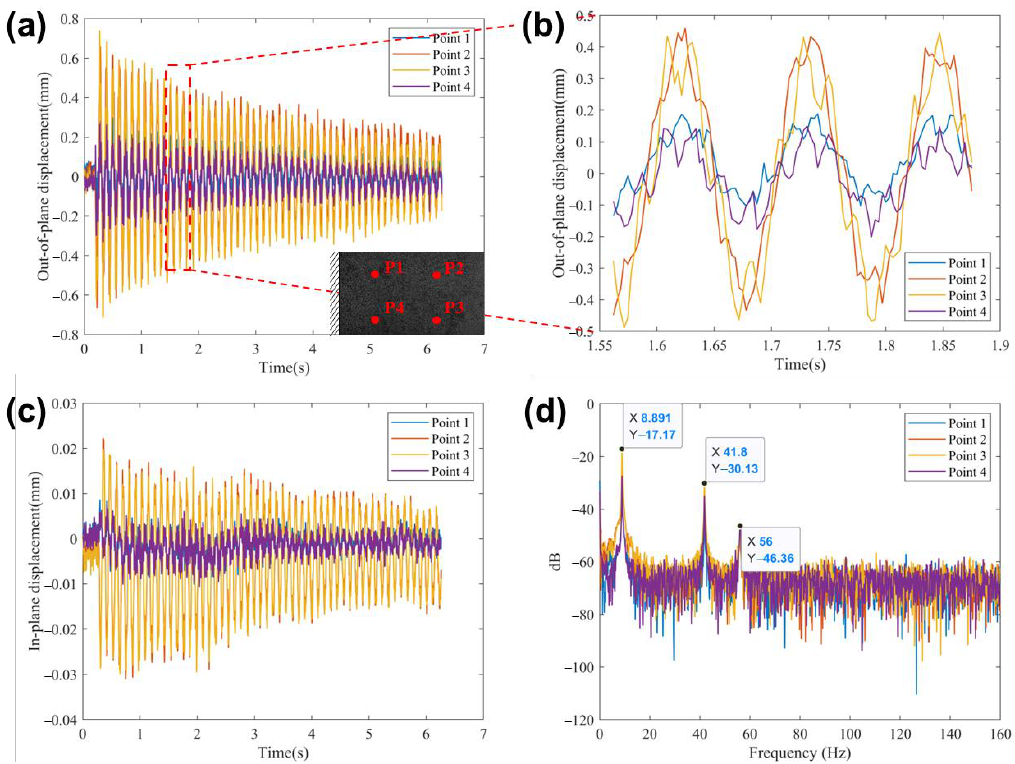
Figure 10. ( a ) The out-of-plane displacements of points P1, P2, P3, and P4, ( b ) a partially enlarged figure of the out-of-plane displacement measurement results, ( c ) the in-plane displacements of points P1, P2, P3, and P4, ( d ) the frequency spectrums of the measured out-of-plane displacements.